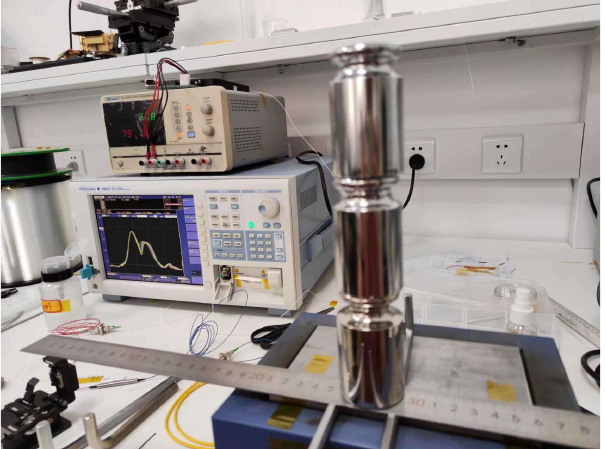
Figure 7. Diagram of the experimental system.